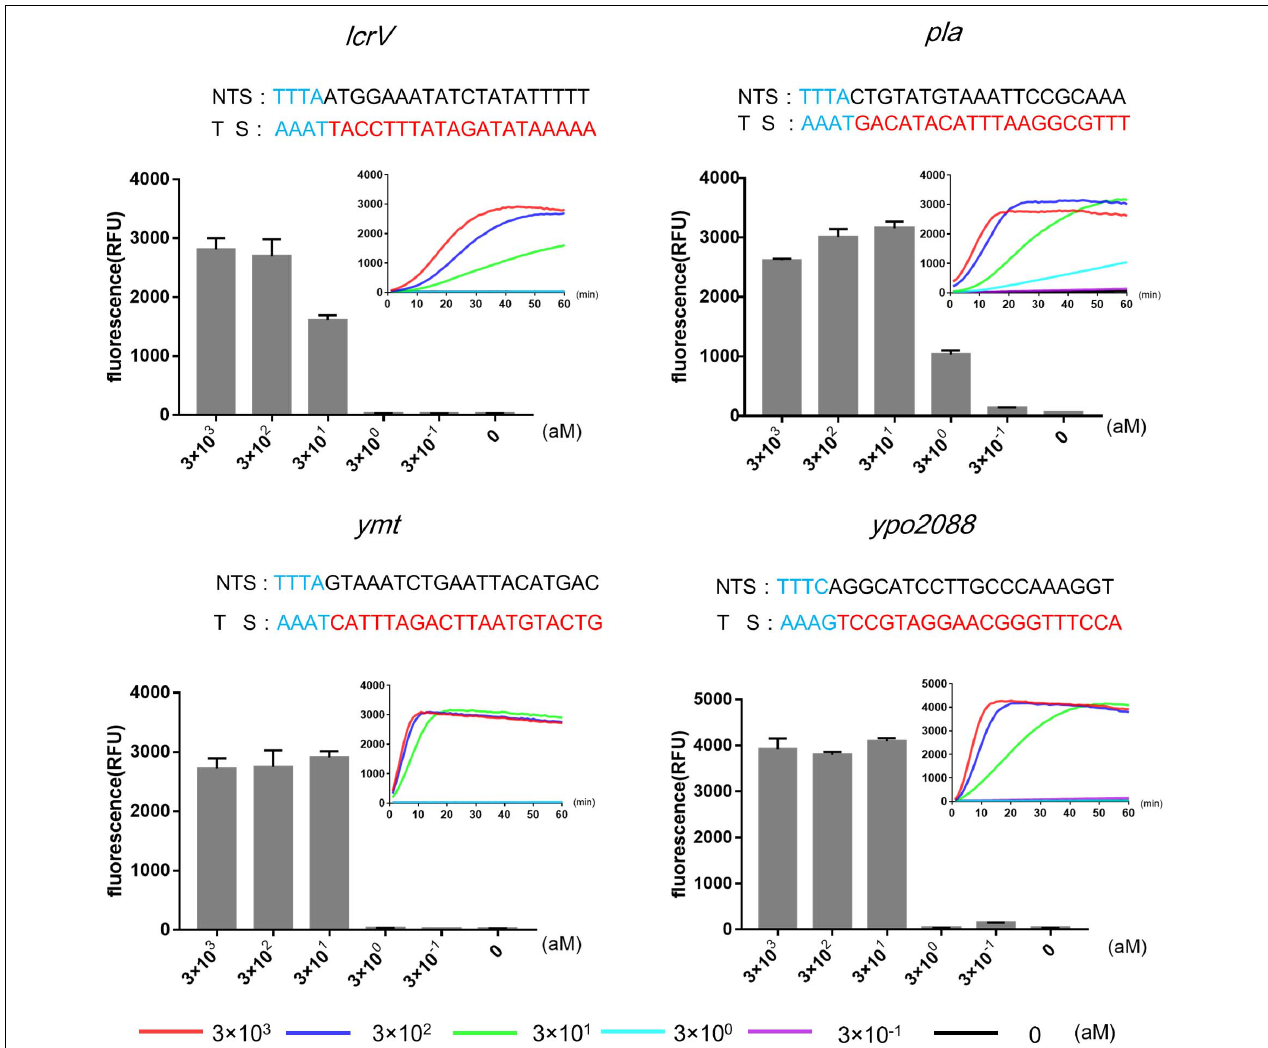
FIGURE 2 | Limits of detections (LODs) of RPA-Cas12a detection of four target genes of Yersinia pestis using different concentrations of genomic DNA (3 × 10 − 1 to 3 × 10 3 aM). Real-time curves show fluorescence signals taken every minute within 1 h. Bar graphs show the endpoint fluorescence intensities detected at 1 h of detection. Data are represented as mean with standard deviation (SD) ( n = 3). LODs, limits of detection; RPA, recombinase polymerase amplification.